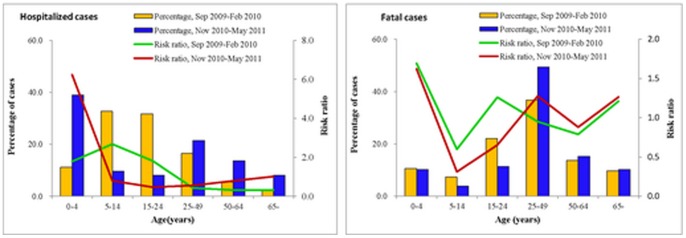
Risk ratio and percentage of hospitalizations and death by age group, China, during the winter season of 2010–2011 and during the 2009 pandemic period.